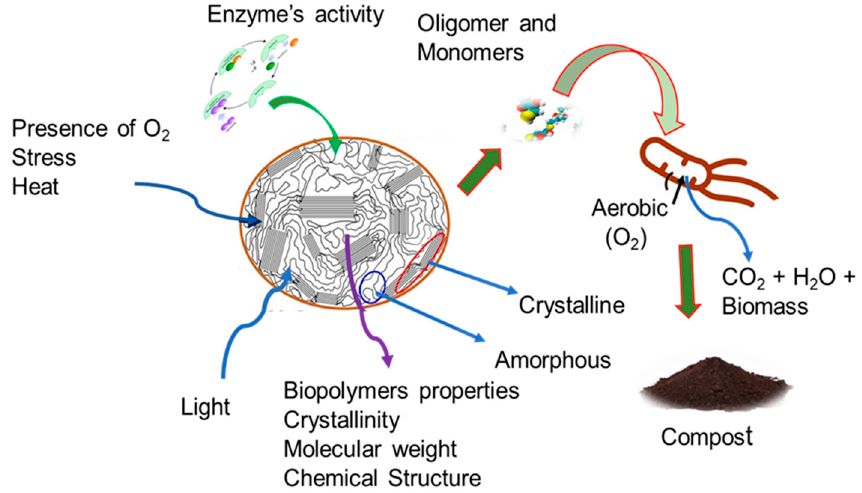
Figure 3. Mechanism of biodegradation of bioplastics through composting.